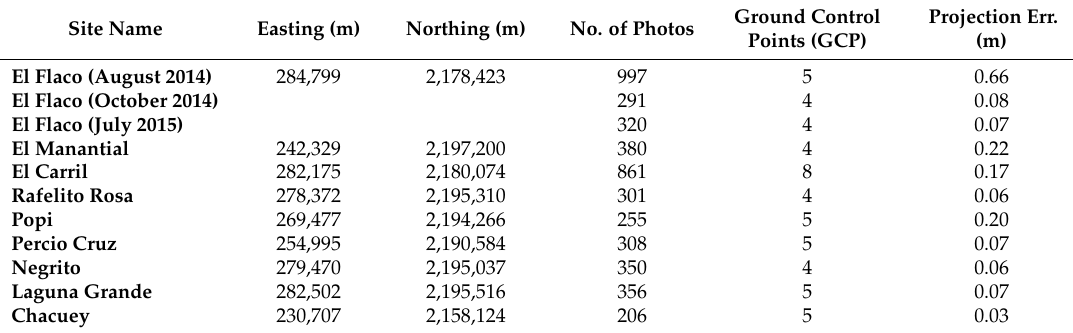
Table 2. Location and data collection information of all flown sites discussed in the text (Coordinate System: UTM WGS84,